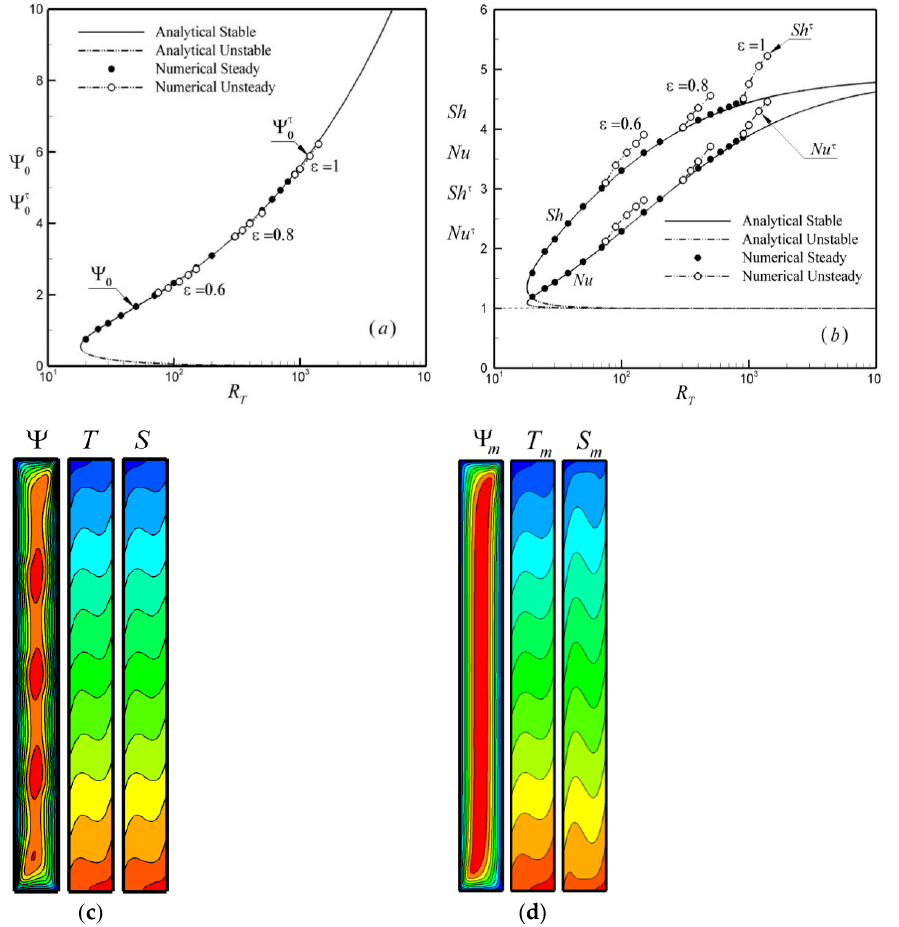
Figure 15. Bifurcation diagram in terms of ( a ) flow intensity, Ψ 0 , and ( b ) local Nusselt, Nu , and Sherwood numbers, Sh , versus Rayleigh number, R T , for A = 10, Da e = 10 − 4 , Le = 2, ξ = 0 and D u = S r = 0.1, ( c ) Contours of stream (left), temperature (middle), and concentration (right) at a given instant of time, and ( d ) streamlines, isotherms and isoconcentrations of the time-period averaged solution for R T = 910, ε = 1 and τ =